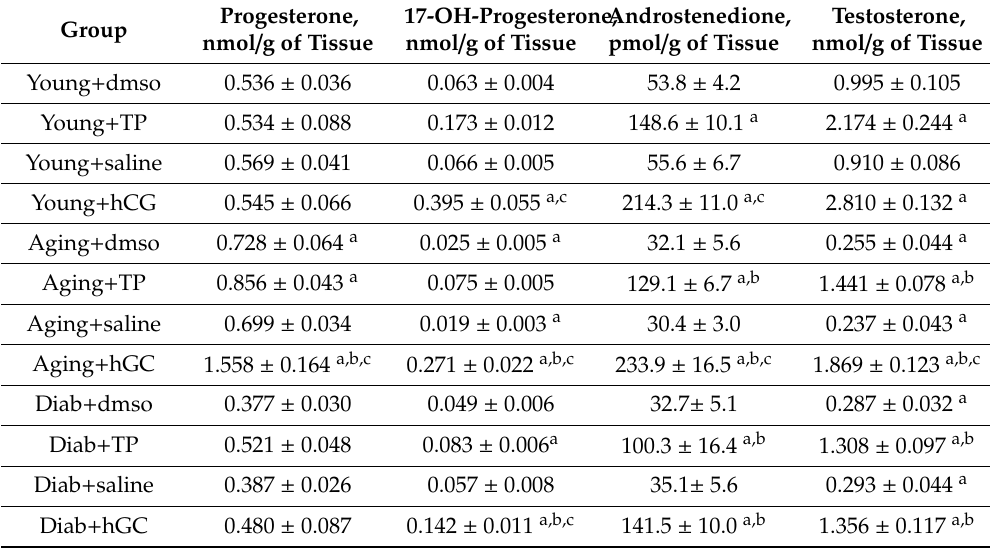
diabetic rats, and the e ff ect of five-day treatment with TP4 / 2 and